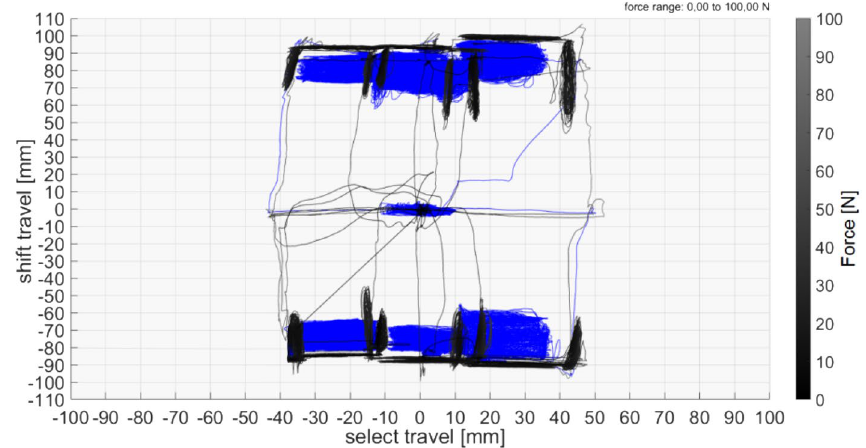
Figure 6. The actual diagram of H pattern and free play.